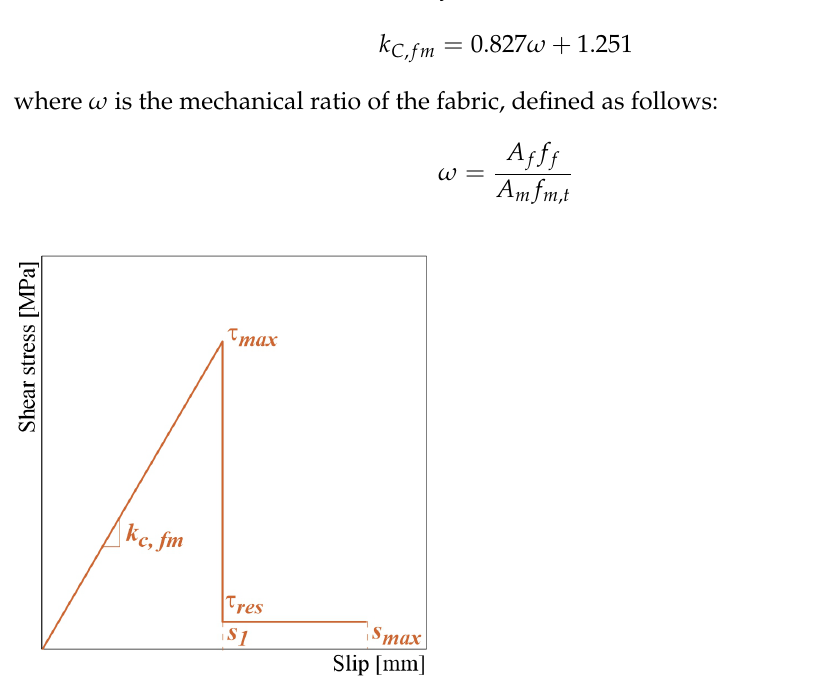
Figure 4. Constitutive law assumed for the fabric-matrix